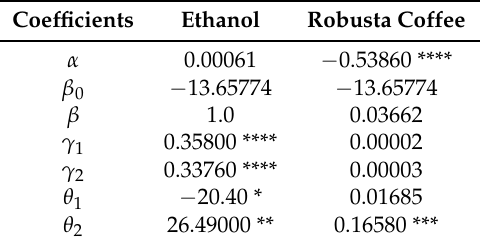
Table 8. The VECM for the ETH-ROB pair in P 5 . Significance levels: 10% (*), 5% (**), 1% (***) and 0.1%